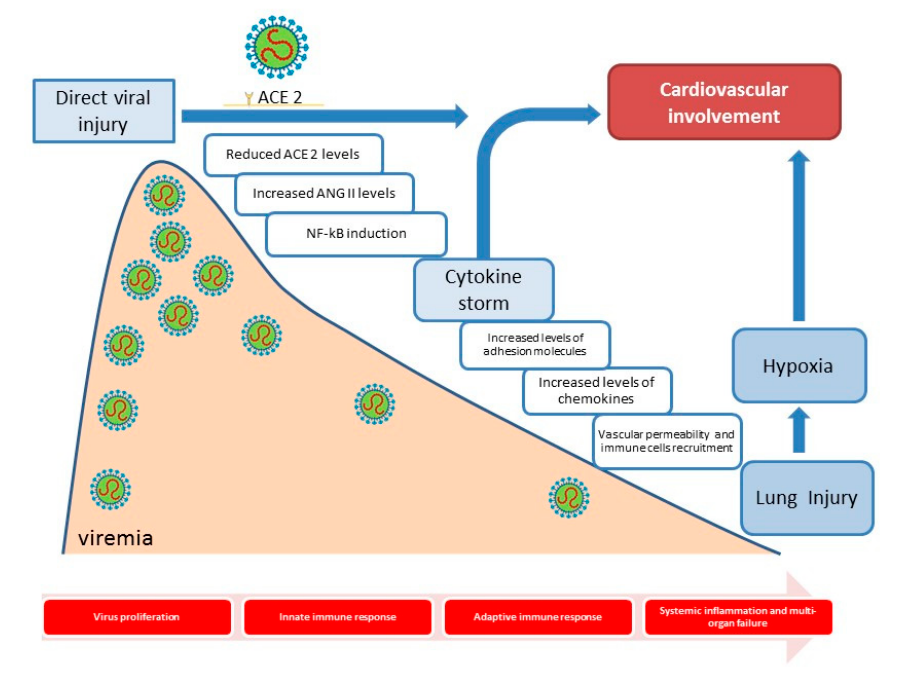
Figure 1. Cardiovascular involvement of SARS-CoV-2 during the various stages of the disease.